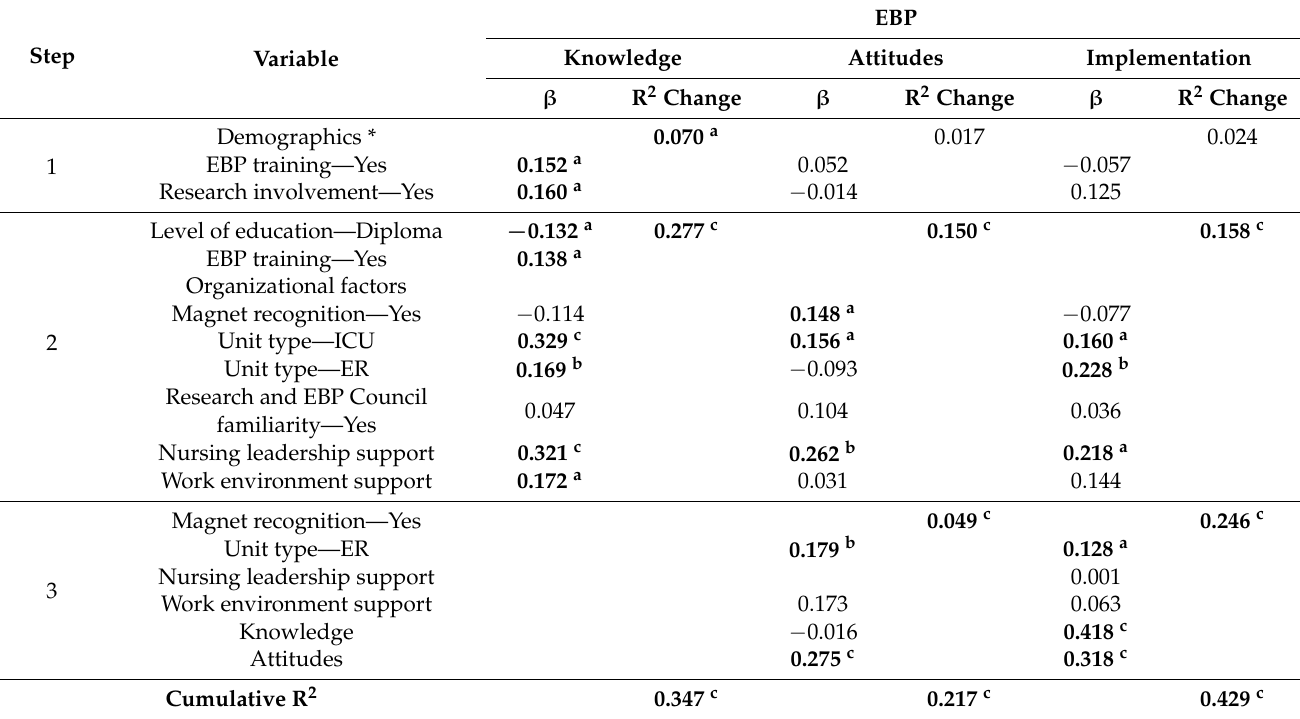
Table 4. Hierarchical multiple linear regression of knowledge, attitudes, and implementation regard- ing EBP among staff nurses (N =